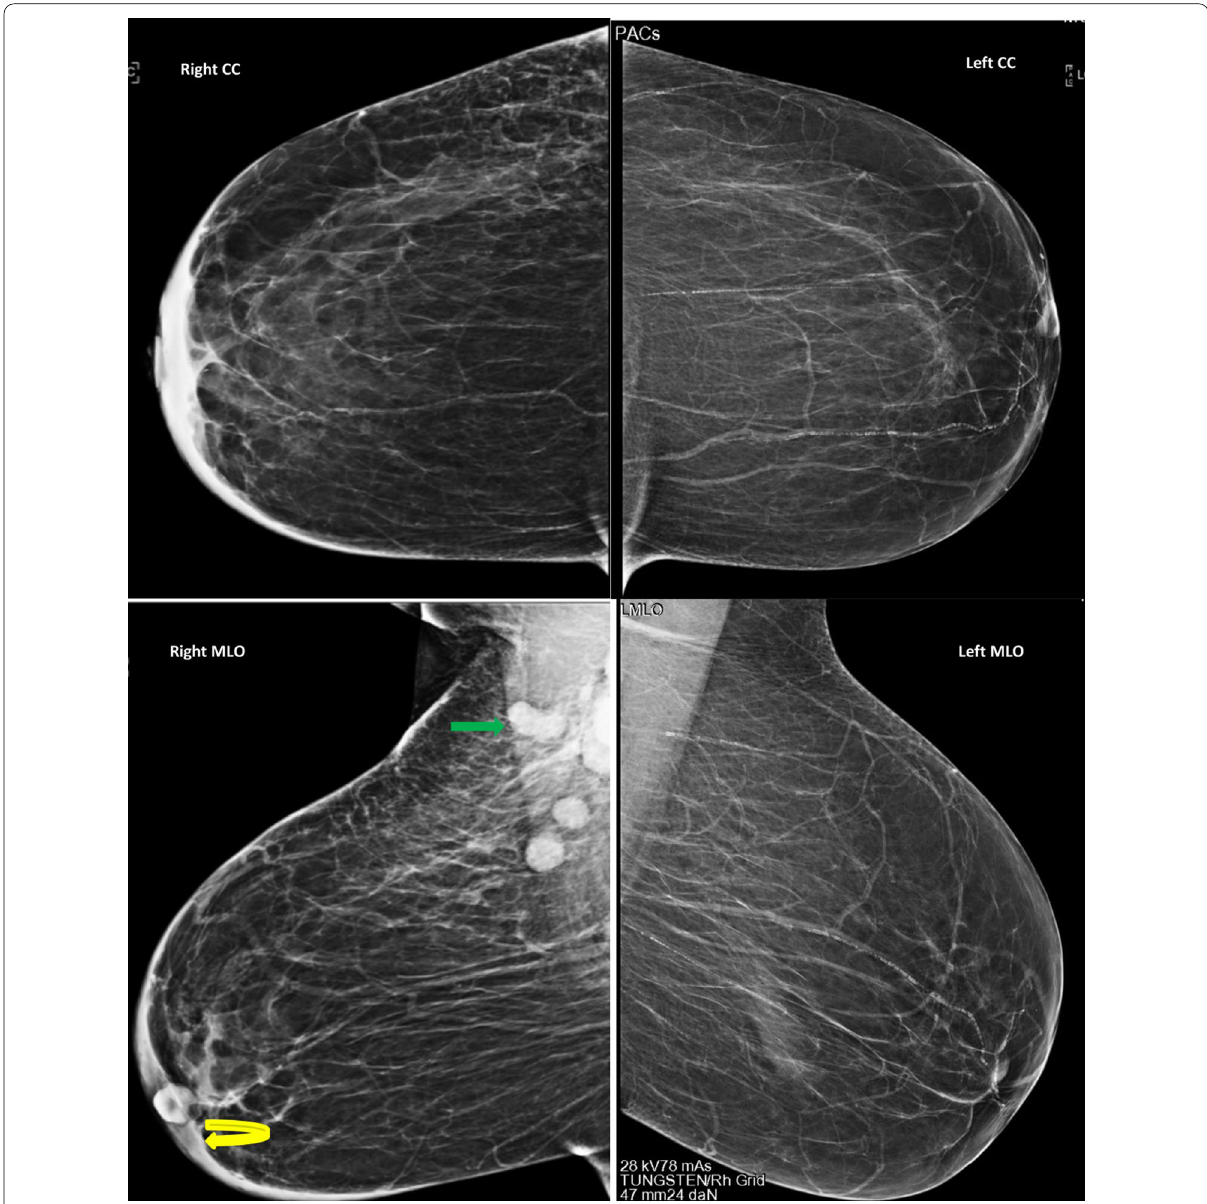
Fig. 1 Craniocaudal and Mediolateral oblique views of both breasts: Right breast shows slight increase in density when compared to the contralateral side. There is diffuse thickening of skin (yellow arrow). This is secondary to lymphatic obstruction because of enlarged ipsilateral axillary lymph nodes. Multiple enlarged malignant looking lymph nodes are seen in right axilla, round in shape with loss of fatty hilum (green